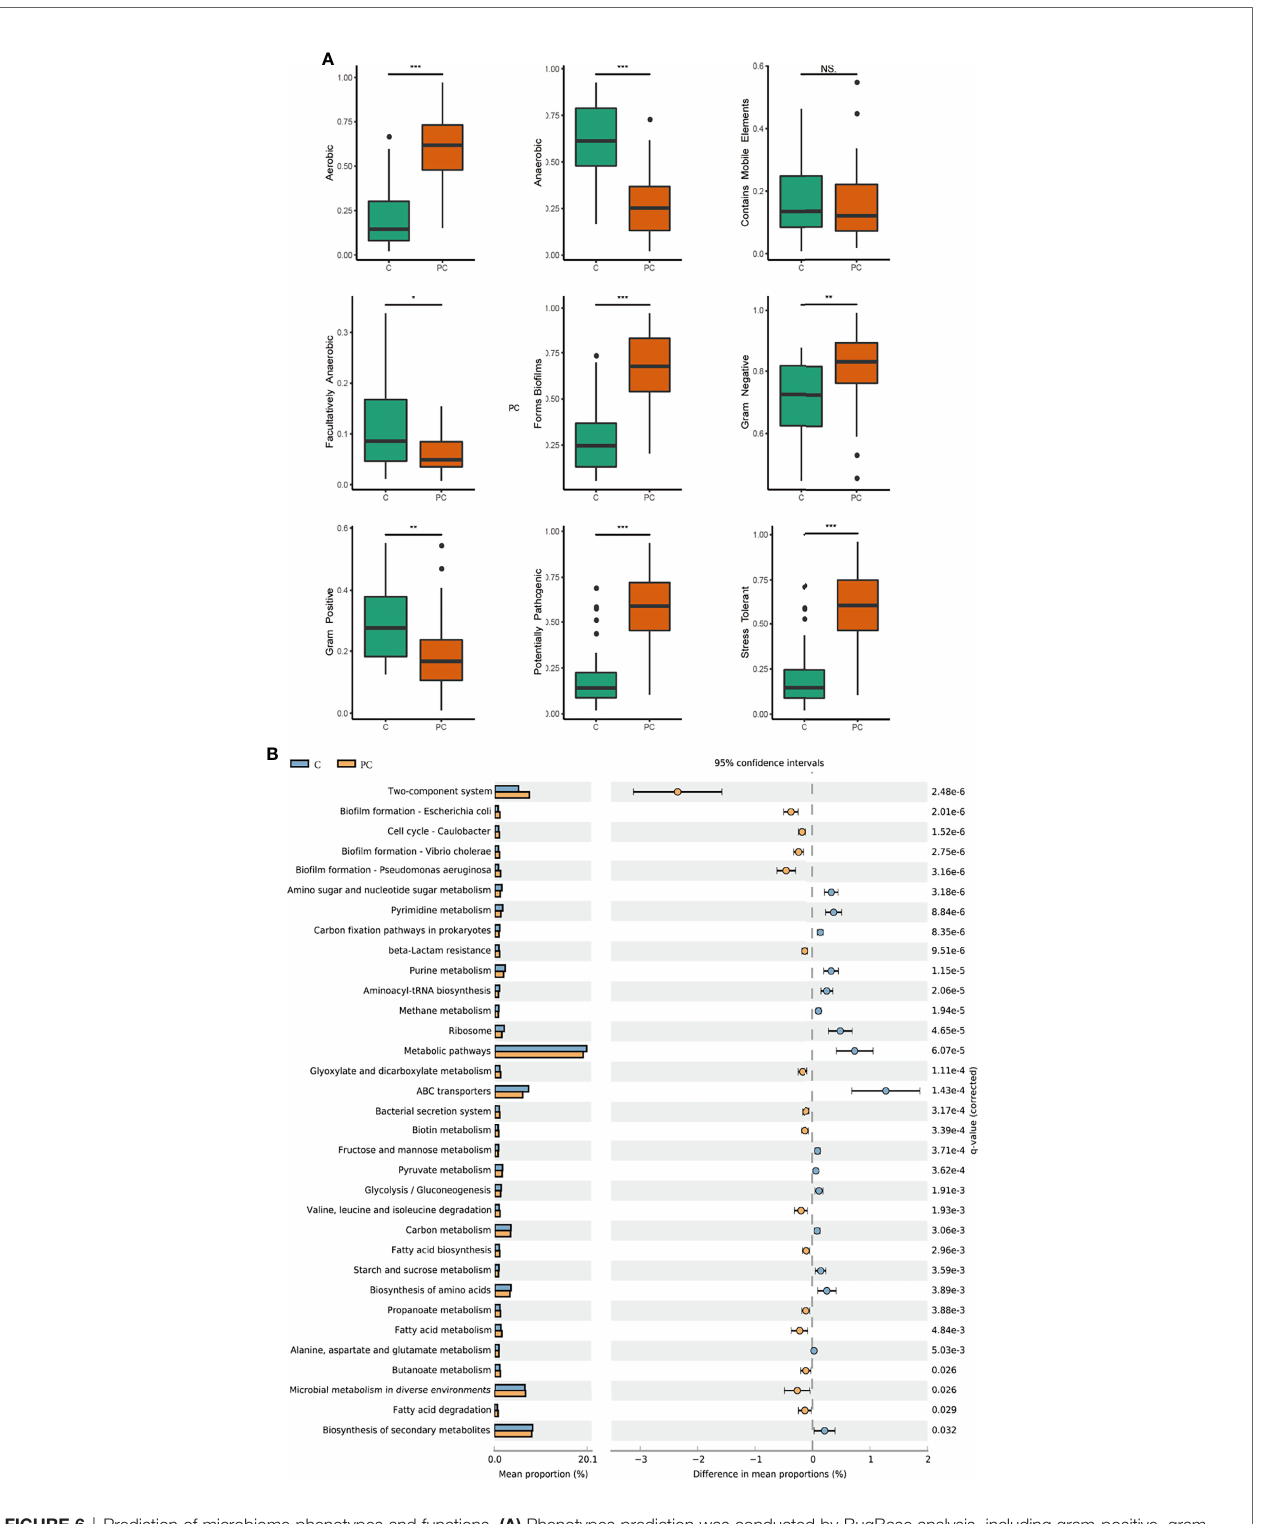
FIGURE 6 | Prediction of microbiome phenotypes and functions. (A) Phenotypes prediction was conducted by BugBase analysis, including gram-positive, gram- negative, bio fi lm forming, stress tolerance, potential pathogenicity, aerobic, anaerobic, facultatively aerobic and mobile elements. (B) Microbial functional pro fi le was predicted by Tax4Fun2 based on the KEGG pathway, and statistically analyzed by STAMP. KEGG pathways with signi fi cant abundance difference (P < 0.05) are shown. C, tumor tissue; PC, paracancerous tissue. ns, no signi fi cance; *P<0.05, **P<0.005,